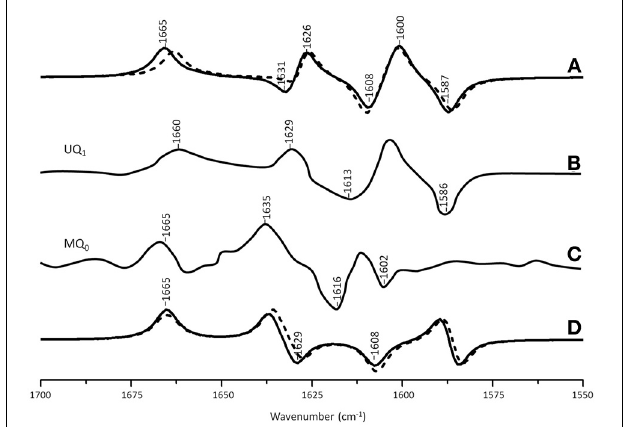
FIGURE 5 | (A) ONIOM calculated 18 O isotope edited DDS for neutral MQ 0 (solid) and UQ 1 (dotted) in the Q A binding site. Experimental spectrum for (B) MQ 0 and (C) UQ 1 are also shown, and were taken from Breton et al. (1994a) with permission. (D) DFT calculated 18 O isotope edited DDS for neutral MQ 0 (solid) and UQ 1 (dotted). ONIOM and gas phase calculated spectra were scaled by 0.9718 and 0.9608, respectively.